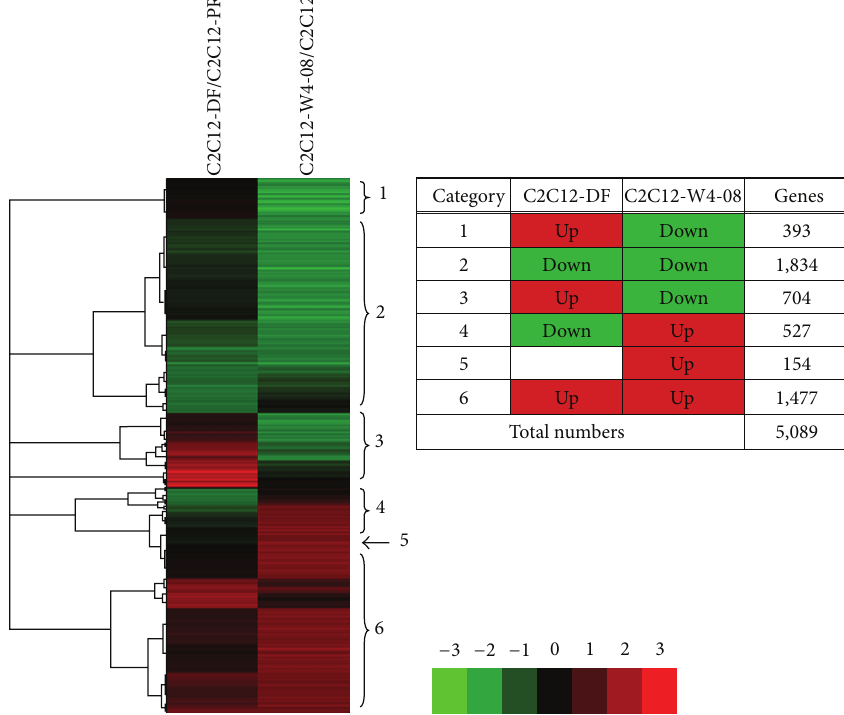
Figure 2: Summary of expression array analysis for C2C12 differentiation and Wnt4 expression. Red and green colors show upregulated and downregulated expression, respectively, with differentiation medium and Wnt4 overexpression. 1477 and 1836 genes were upregulated and downregulated, respectively, in differentiation medium and Wnt4 overexpression at a twofold magnitude. Refer to original data in supplementary 1 for